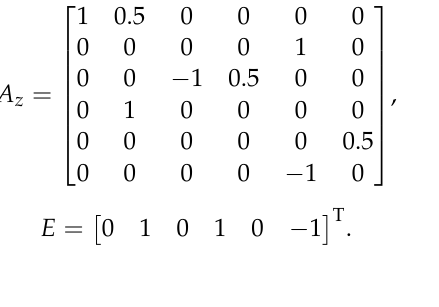
Table 2. Actuator fault f a ( t )